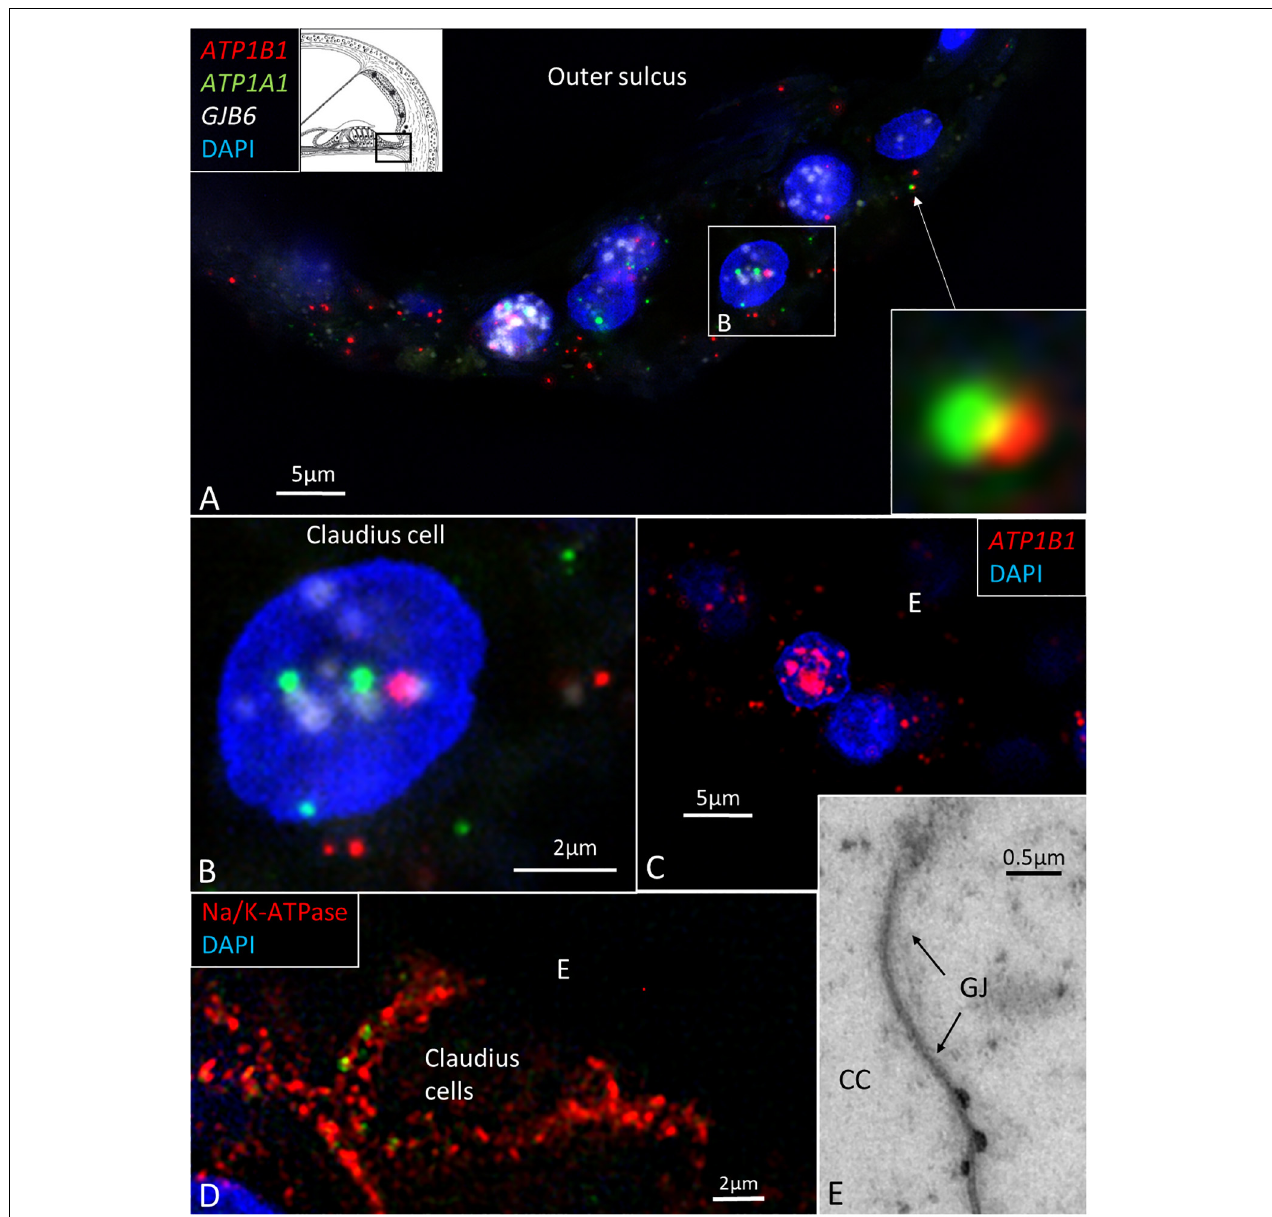
FIGURE 7 | (A) SR-SIM of Claudius cells in a human cochlea. ATP1B1 , ATP1A1 , and GJB6 gene transcripts are expressed in cell nuclei and cytoplasm. Two gene puncta appear close to each other. Framed area is magnified in (B) . (B) Cell nucleus contains all three genes. (C) Claudius cell nucleus contains a large number